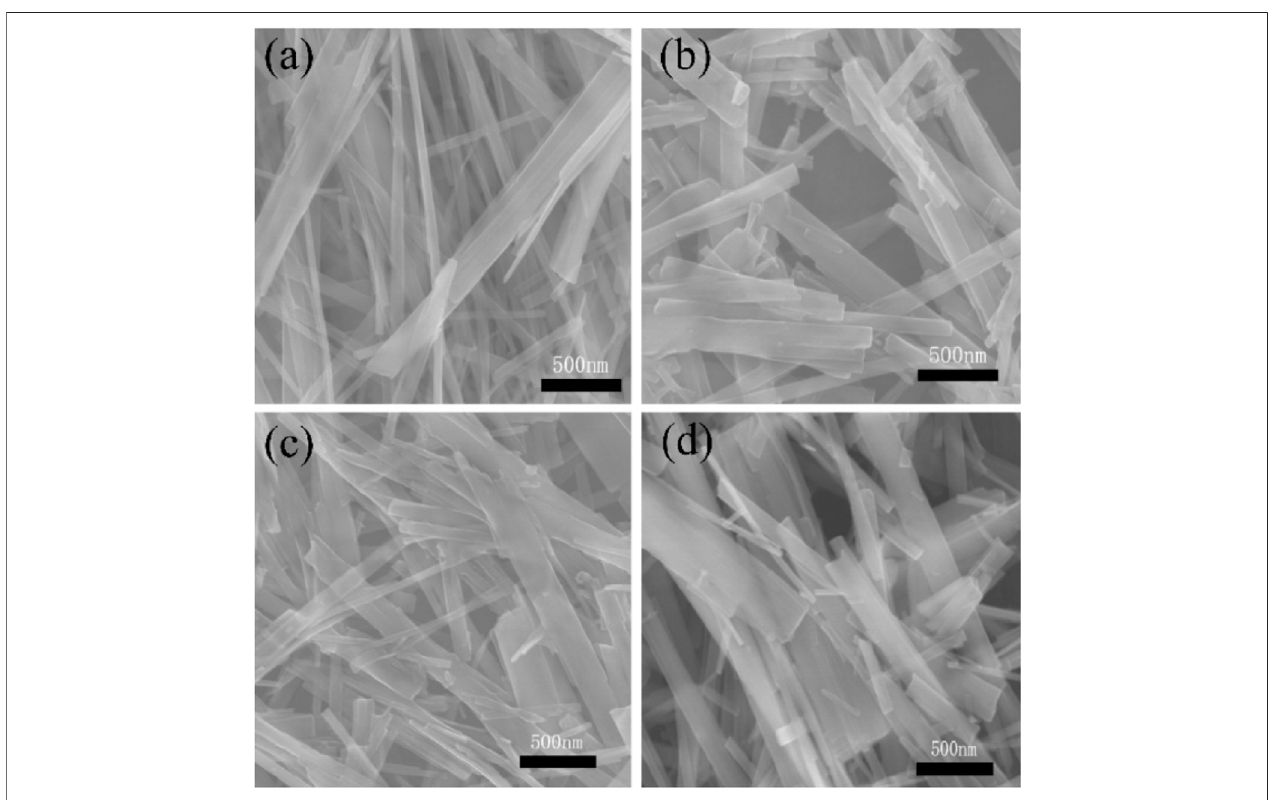
FIGURE 4 | SEM images of (A) TiO (B) TiO 2 nanobelts, 2 nanobelts calcined at 400 ° C for 3 h in air, annealed at 400 ° C for 3 h under a H 2 /Ar atmosphere. Adapted from Xie et al. (2021). Copyright © 2021 Capital Normal University. Published by Elsevier B.V.